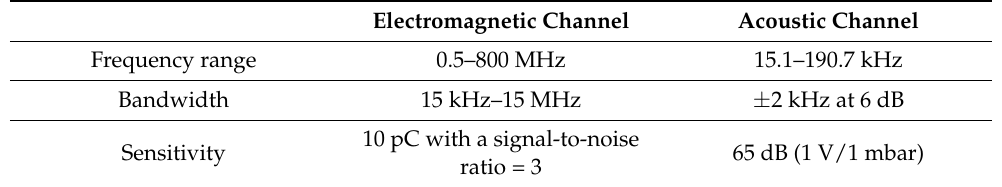
Figure 2. Structural diagram of the acoustic ( a ) and electromagnetic ( b ) PD measurement systems in insulators. Table 1. Technical characteristics of the measuring complex.